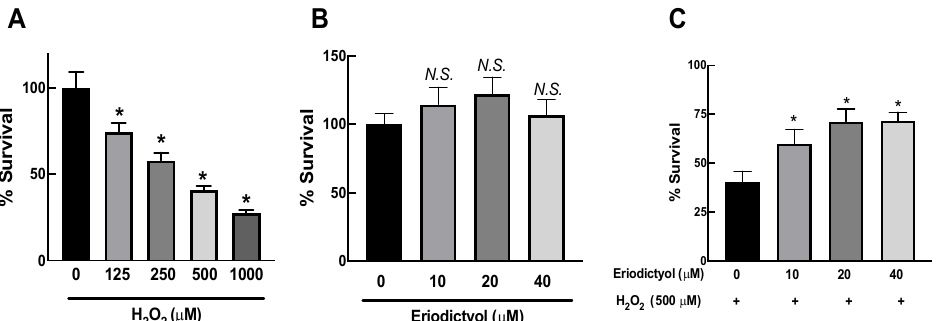
Figure 1. Eriodictyol inhibited H 2 O 2 -induced cytotoxicity in dermal fibroblasts. ( A ) H 2 O 2 exposure